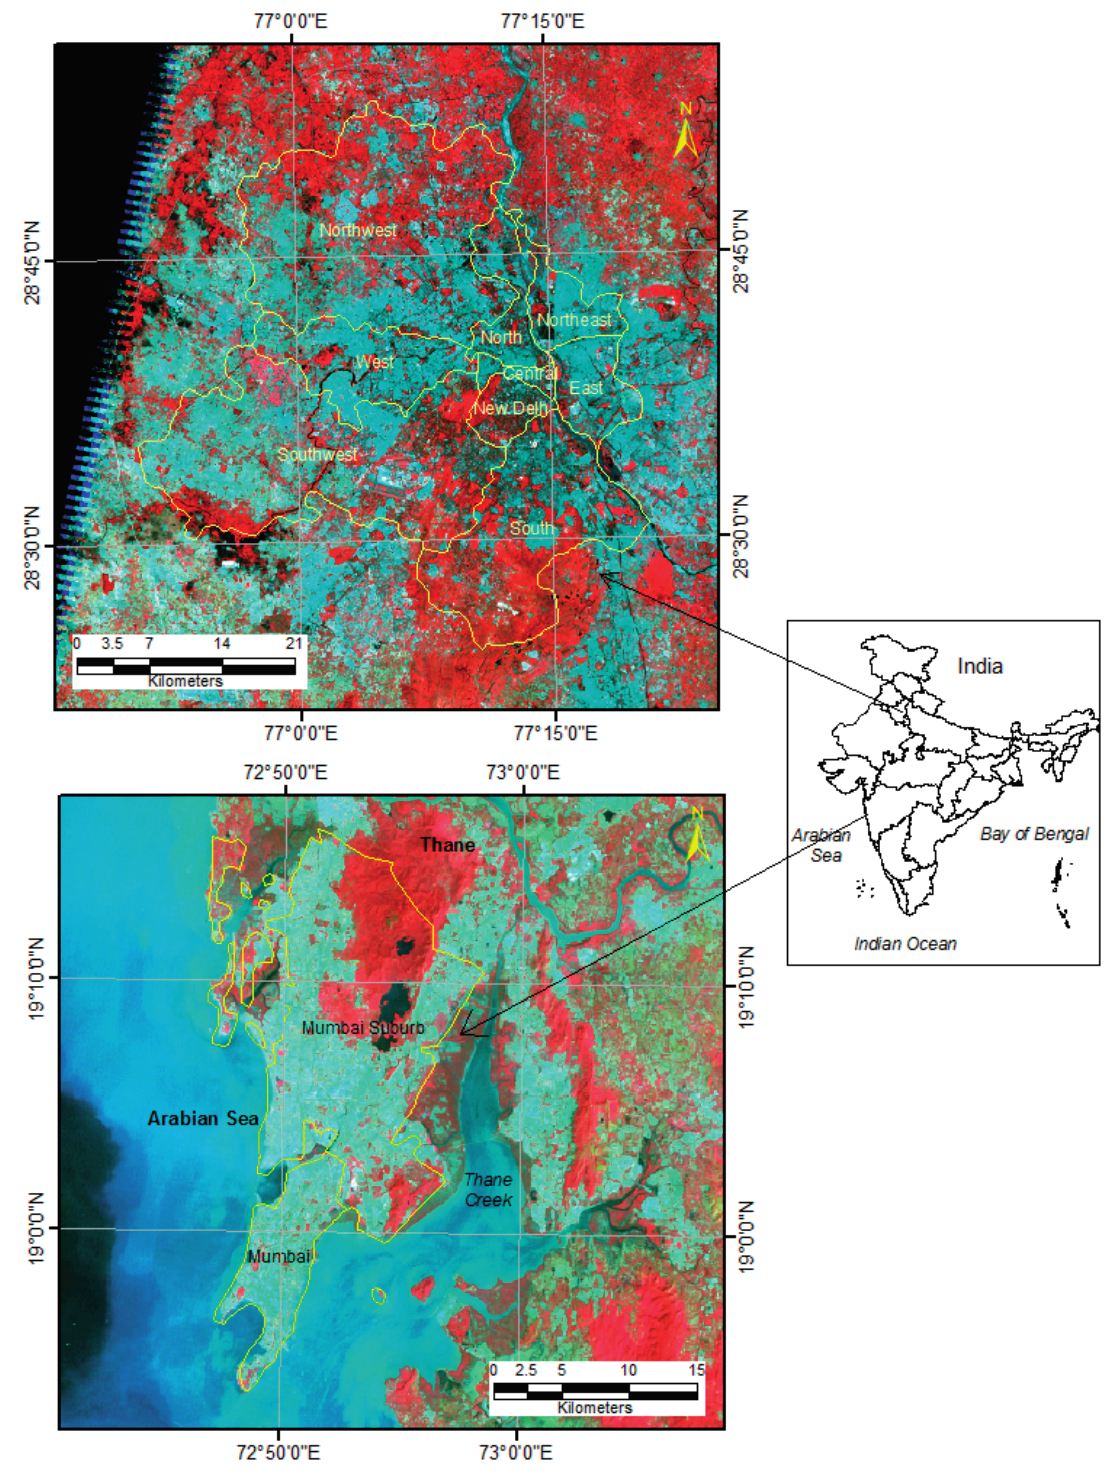
Figure 1. Location of the cities of Delhi and Mumbai in India. Landsat 5 TM images are in the